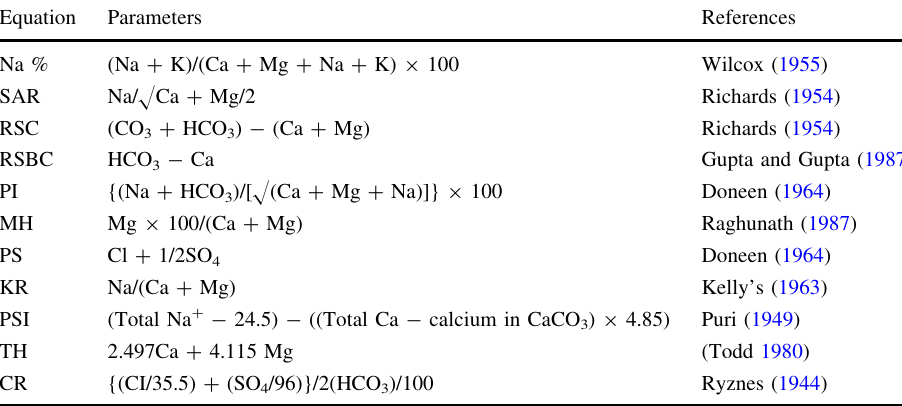
Table 6 List of formula different in parameters